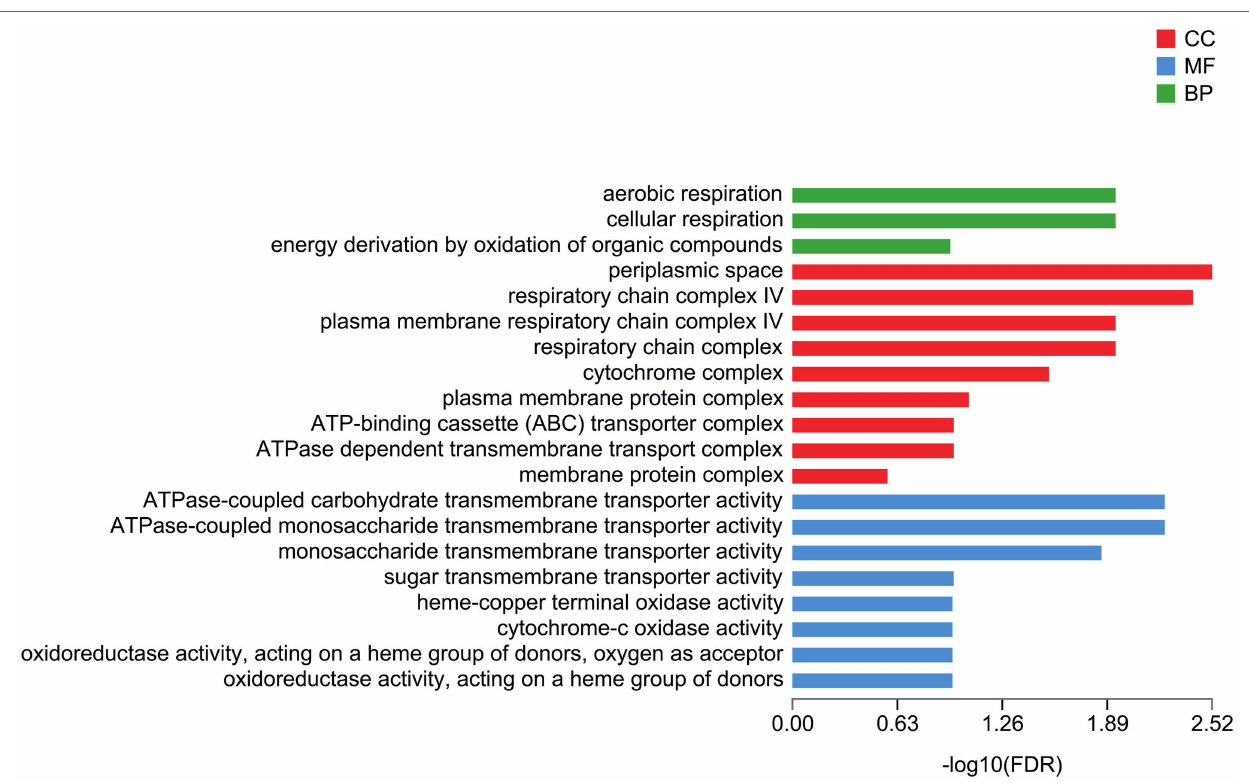
FIGURE 6 | GO enrichment analysis of downregulated genes. X-axis, − log 10 (FDR); Y-axis, functional categories.